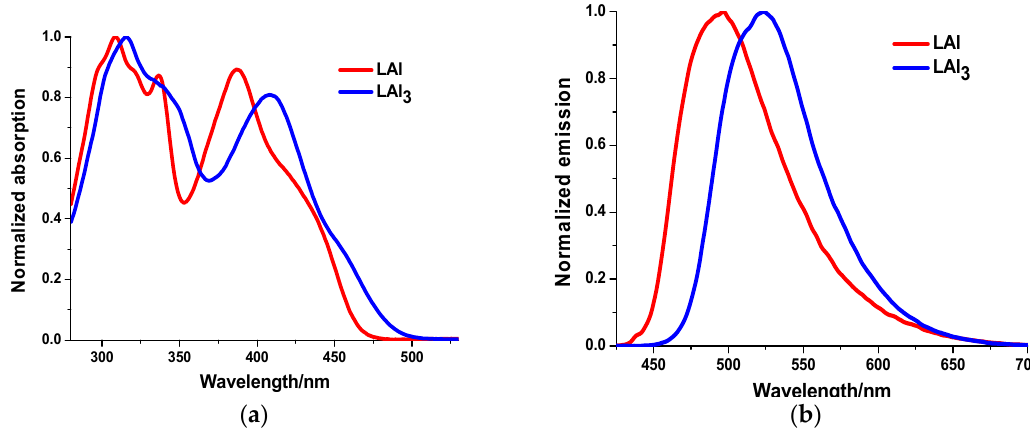
Figure 3. UV–Vis and fluorescence spectra of the Al salophen complexes. ( a ) Normalized UV–Vis absorbance spectra in DMSO at 298 K of LAl and LAl 3 ; ( b ) Normalized emission spectra in DMSO at 298 K of LAl and LAl 3 ( λ ex = 396 nm).